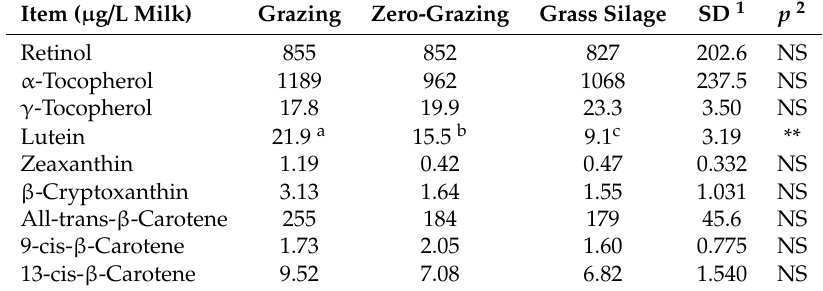
Table 4. Fat-soluble antioxidants composition according to mode of supply of herbage to dairy cows: grazing, zero-grazing or grass silage. Item ( µ g / L Milk) Grazing Zero-Grazing Grass Silage SD 1 p 2 Retinol 855 852 827 202.6 NS α -Tocopherol 1189 962